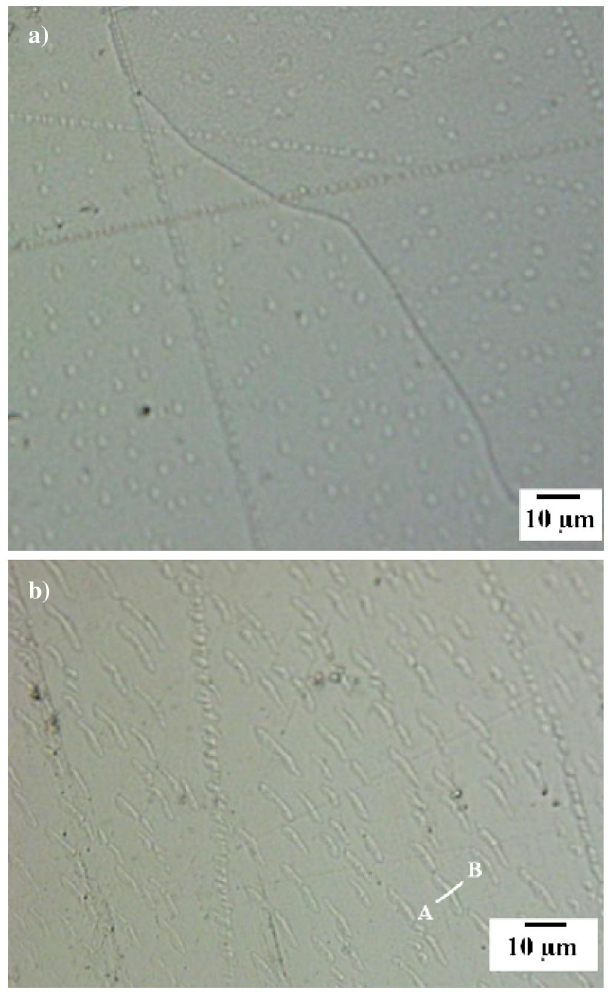
FIG. 3. Lenslike structures after 77 K hold on mechanically polished (a) fine grain sample; (b) single grain sample.